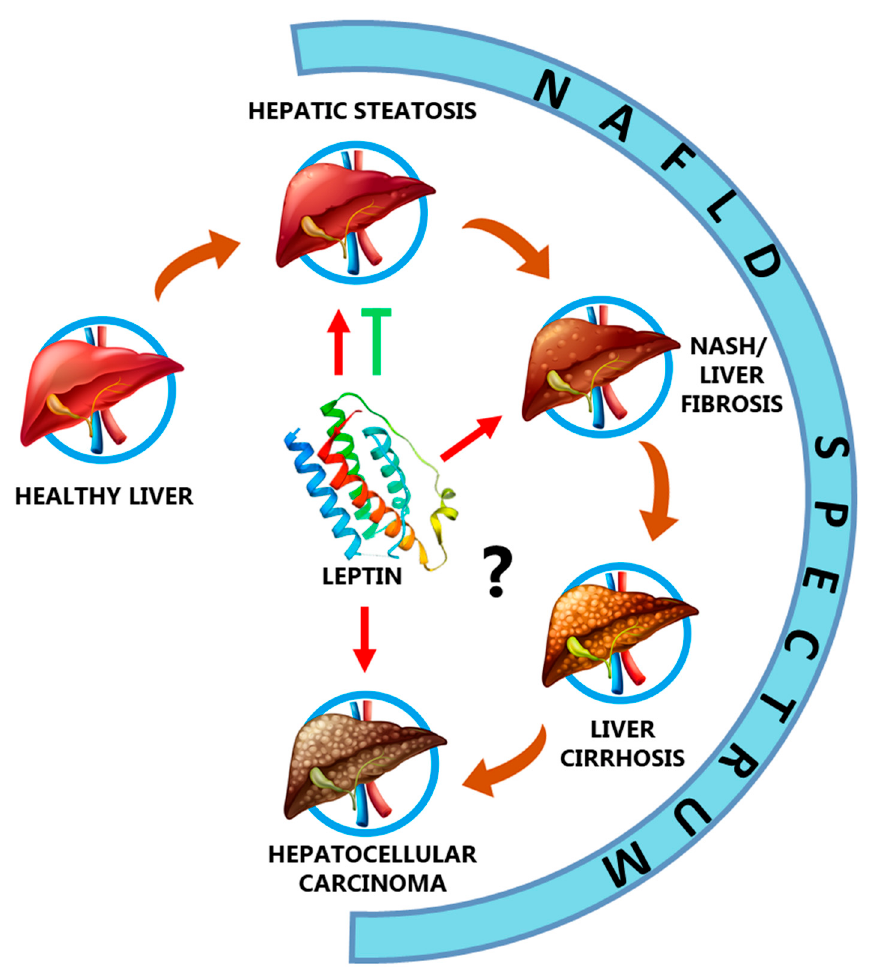
Figure 2. Role of leptin in the NAFLD spectrum. Leptin has been demonstrated to have antisteatotic effects, although this hormone could also contribute to worsening of hepatic steatosis under certain circumstances such as hyperleptinemia. In addition, leptin is involved in the pathogenesis of NAFLD by promoting NASH and liver fibrosis. However, the role of leptin in NAFLD-related cirrhosis and NAFLD-related hepatocellular carcinoma is unknown, but there is much evidence to confirm the protumoral role of this adipokine in liver malignancies Table 1.